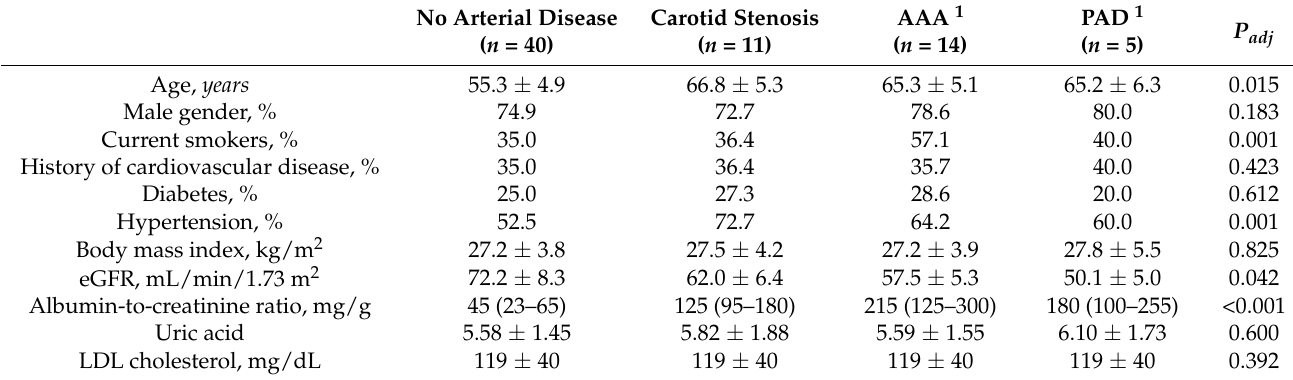
Table 1. Characteristics of the study patients stratified by arterial disease type.